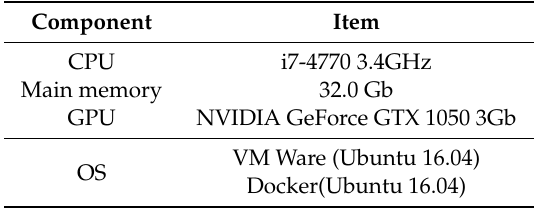
Table 3. Specifications under which the remaining parts